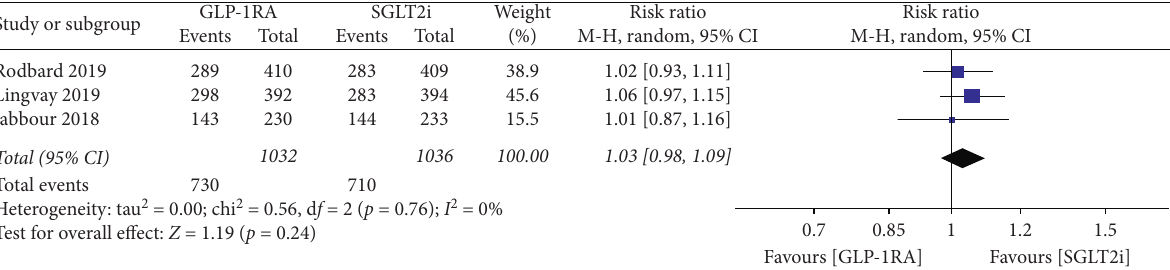
Figure 4: Forest plot for meta-analyses comparing the overall safety of GLP-1RAs with SGLT-2is. AEs leading to discontinuation includes injury, angioedema and infections, etc. AEs: adverse events, GLP-1RAs: glucagon-like peptide 1 receptor agonists, SGLT-2is: sodium- glucose cotransporter 2 inhibitors, CI: confidence